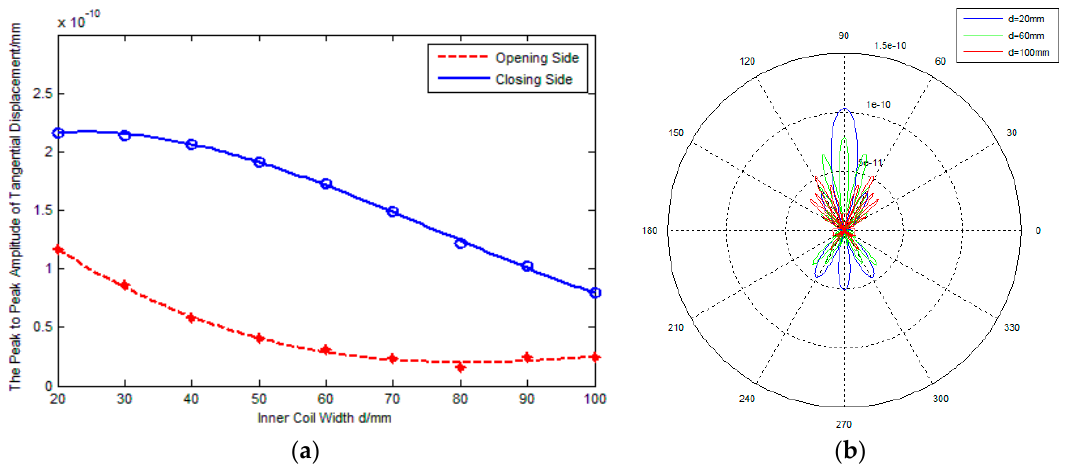
Figure 3. Influence of d on performance of PPM EMATs: ( a ) d -signal amplitude; ( b ) d -radiated acoustic field .